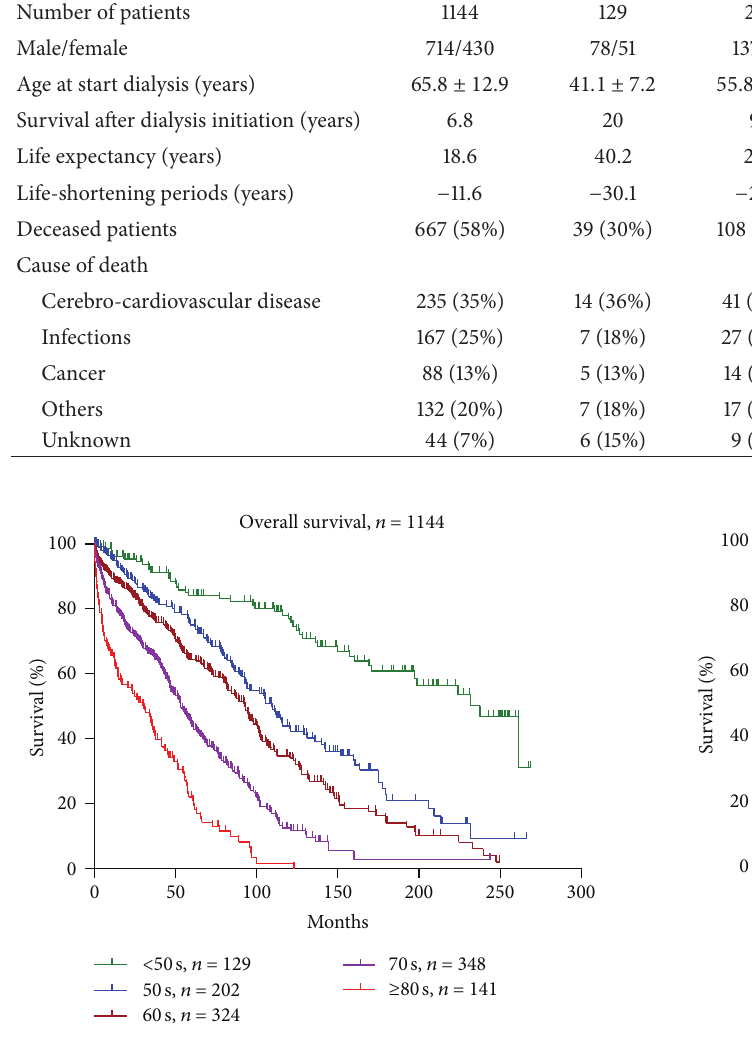
Figure 2: Overall survival in 1144 dialysis patients according to age.